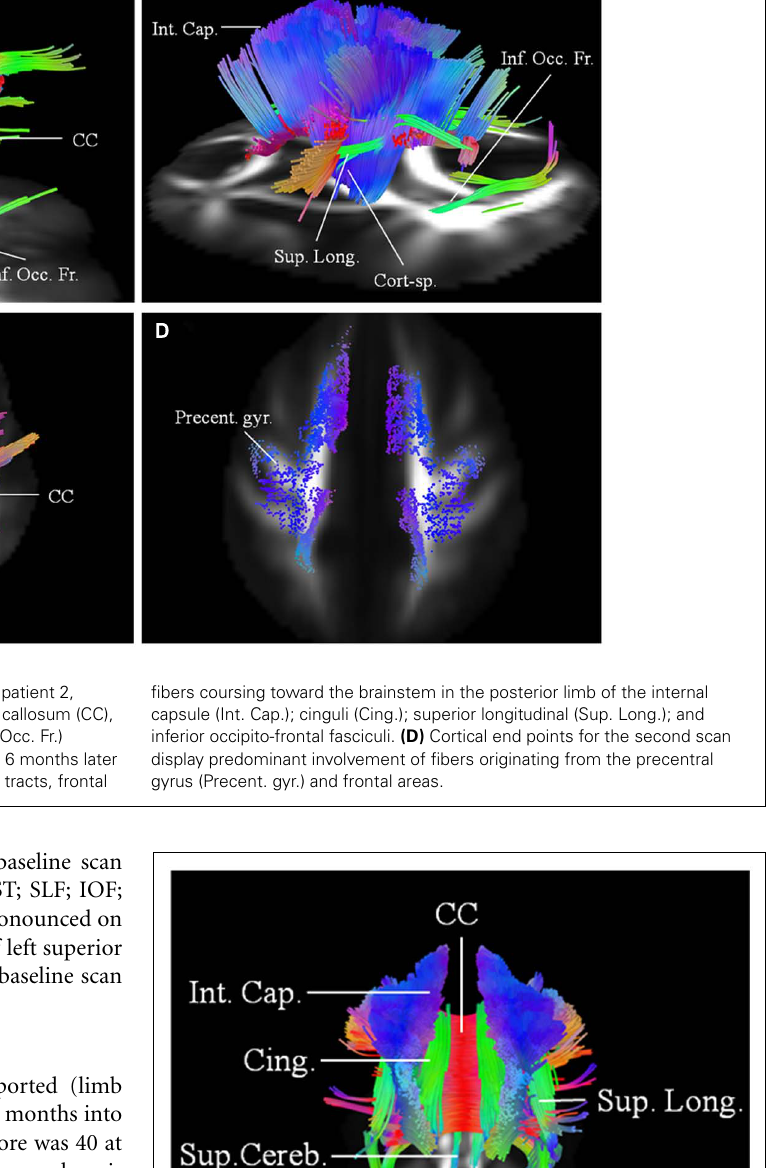
FIGURE 4 | Baseline scan (posterior view) in patient 3, demonstrating evidence of extensive motoric and extramotoric changes in the white matter tracts [corpus callosum (CC); internal capsule (IC); Superior longitudinal (Sup. Long.) fasciculus; Cingulum (Cing.)] with changes being more pronounced on the right; also noted was involvement of the left superior cerebellar peduncle (Sup. Cereb.).